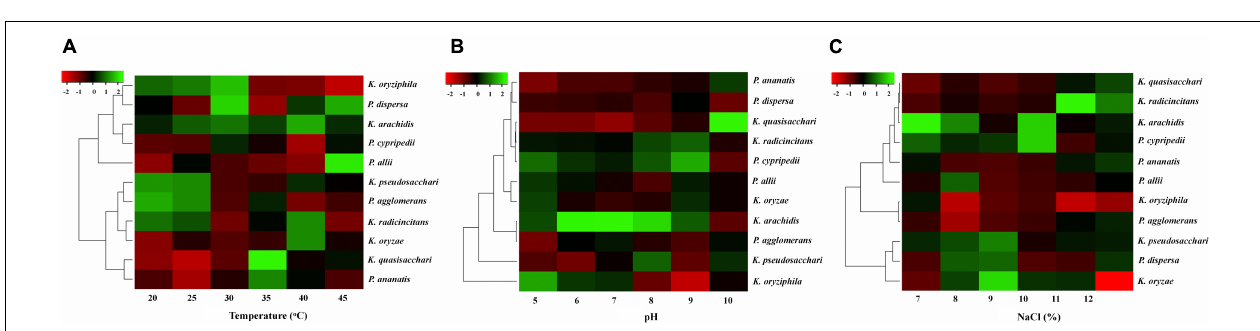
FIGURE 5 | Images obtained by scanning electron microscopy of the antagonistic bacteria interacting with hyphae of selected fungal pathogens on NA: PDA medium after 5 days incubation. (A,D) indicating a normal hyphae of F. verticillioides and F. oxysporum f. sp. cubense , whereas (B,C,E,F) , indicating abnormal hyphae of selected fungal pathogens.